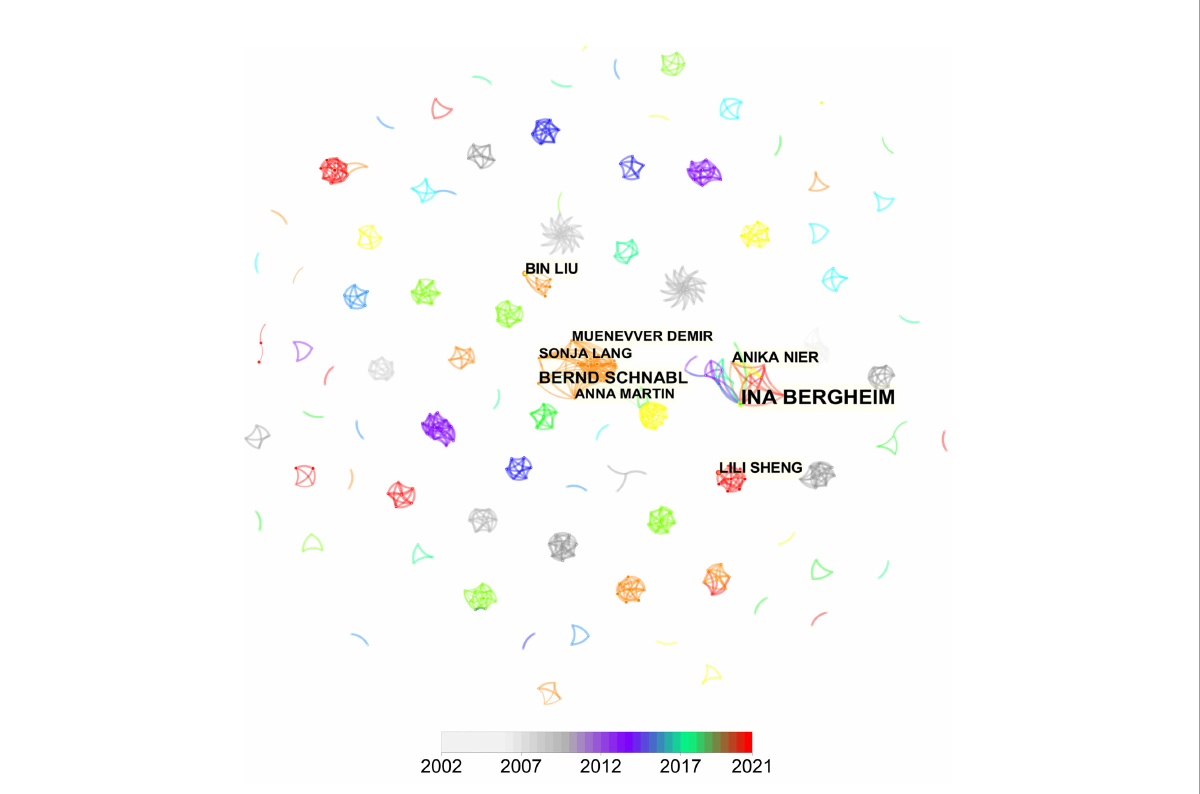
FIGURE 4 CiteSpace network of authorship in the links of gut microbiota and MAFLD research. The top 8 authors with the most publications are shown. Each circle represents an author and links between two circles mean a collaboration between each other. Font size is positively associated with the number of articles published by a certain